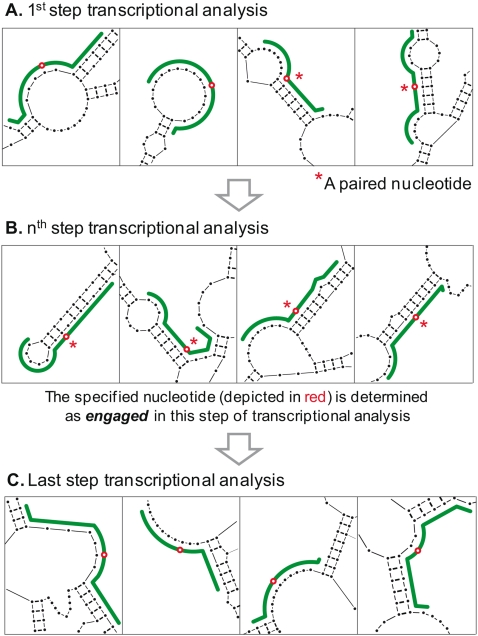
Definition of an engaged nucleotide in a particular step of transcriptional analysis.(A) to (C). This is to illustrate that multiple secondary structures of the targeted exon (drawn in green) are predicted in each step of transcriptional analysis, with some of the possible structural motifs shown here. For illustration purpose, a particular nucleotide (marked in red) within an AON target site (green line) is tracked. When this nucleotide is paired (denoted with *), it is not accessible for AON binding. If this nucleotide is paired in all predicted secondary structures, this nucleotide is defined as an engaged nucleotide at this particular step of transcriptional analysis (B).